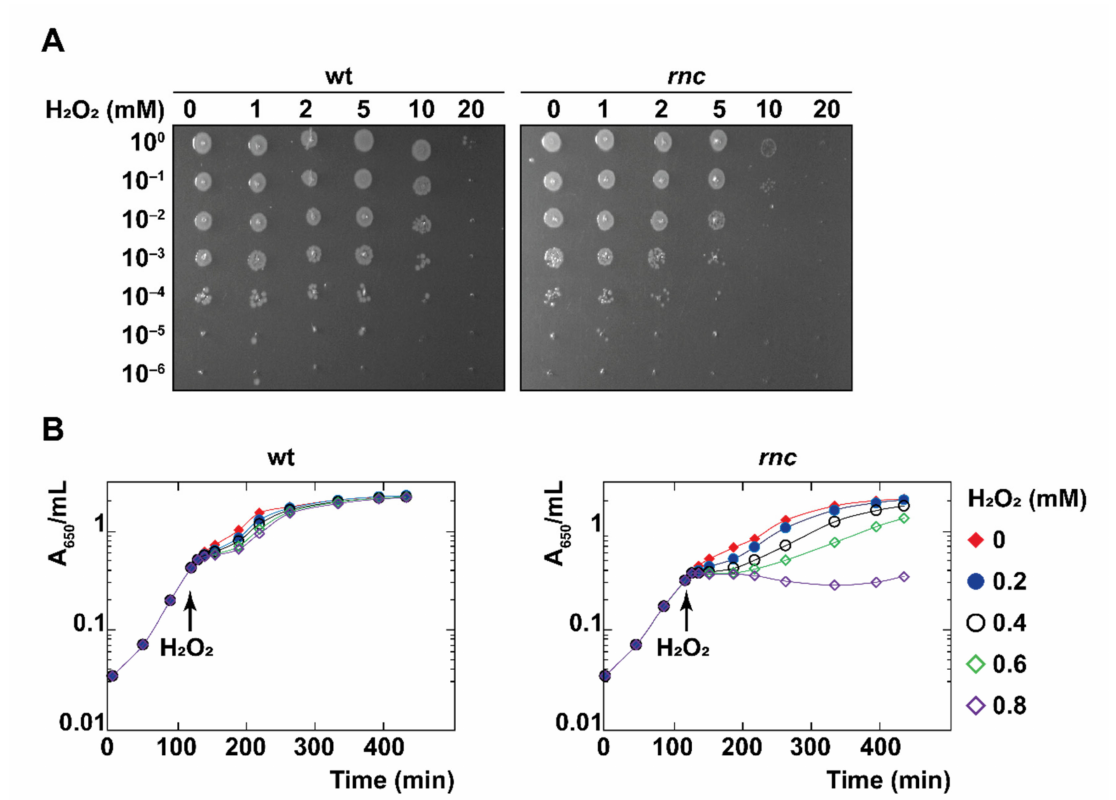
Figure 2. RNase III is required for survival under oxidative stress. ( A ) Strains wt and rnc were grown until mid-log phase, exposed to H 2 O 2 at the indicated concentrations for 10 min, and survival was assayed by droplet plating. ( B ) Strains wt and rnc were grown at 37 ◦ C and H 2 O 2 was added to the cultures in mid-log phase, as indicated by a black